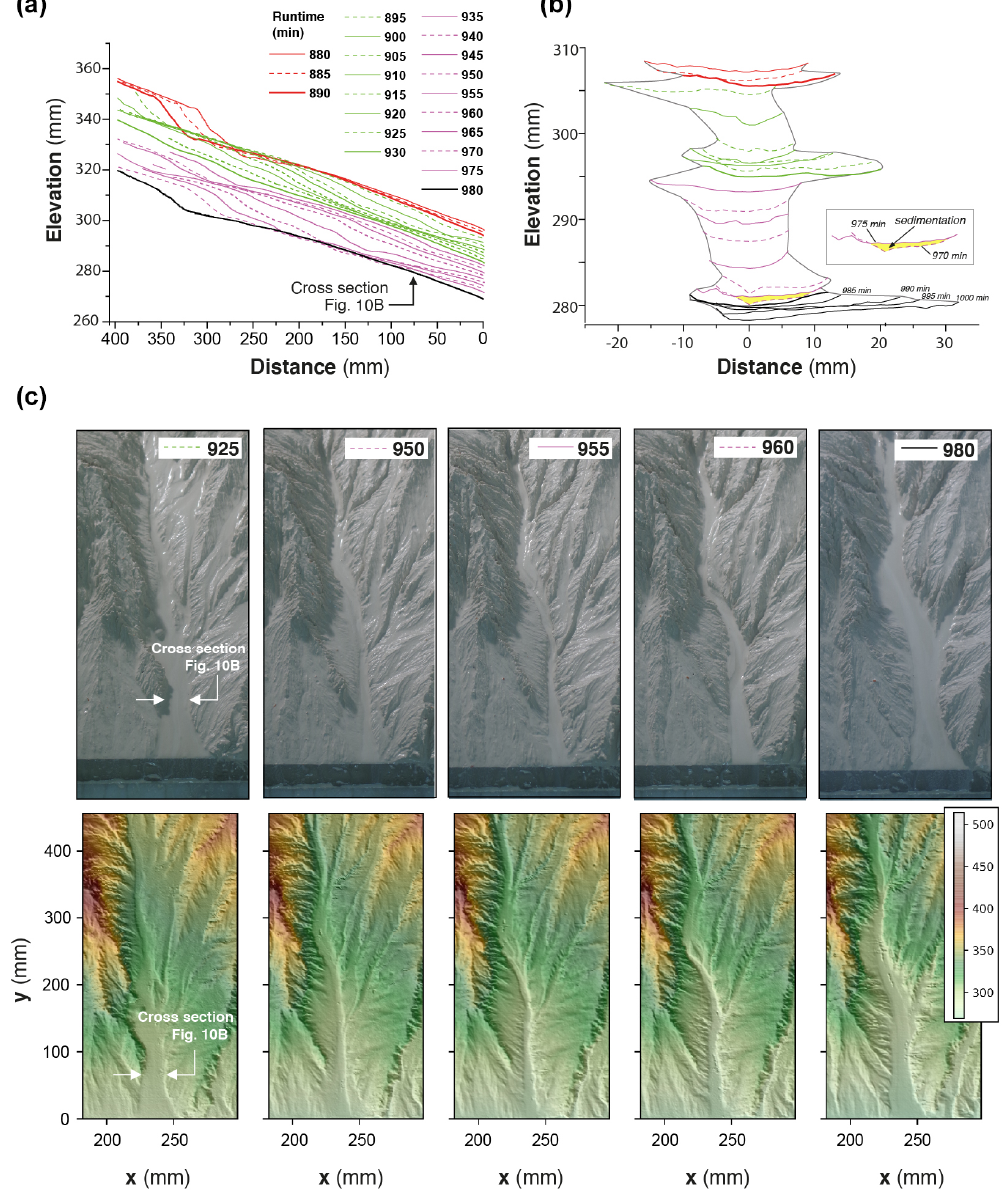
Figure 10. Downstream knickpoint initiation and propagation in a 120min long sequence of experiment BL15 from experimental runtime 880 to 1000min. (a) Sequence of downstream longitudinal profiles (5min time interval) of the investigated river, corresponding to the sequence hydro-geomorphic parameters shown in Figs. 11 and 12. Propagation of the first (K1; initiated at 895 (cid:48) ) and second (K2; initiated at 935 (cid:48) ) knickpoints is shown in green and purple colors, respectively (see text). (b) Time evolution of successive cross sections of the channel at 80 mm from the outlet. Colors are the same as in Fig. 10a. (c) Photos (top row panels) and perspective views of DEM (bottom row panels) at five time steps. Color bar is elevation in